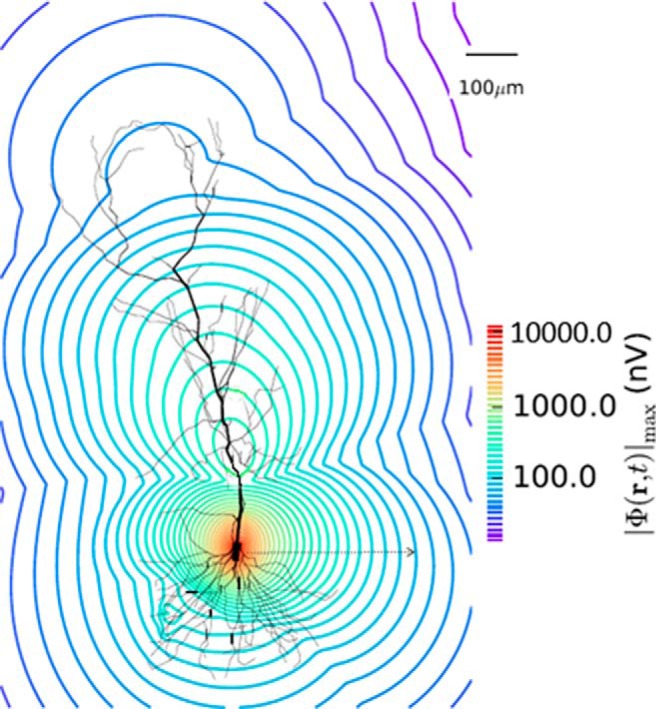
Spatial attenuation. We estimated the spatial extent of the generated LFP using our models. PYR cell model morphology is shown with calculated signal decrease from an electrode positioned near the cell soma. The dotted arrow shows the extent of the spatial reach of the signal that is taken as a 99% decrease in the signal, and is ∼300 μm. Parameter values used are from the predicted regime; gsb = 5, gbs = 5.75 nS, csb = 0.21.